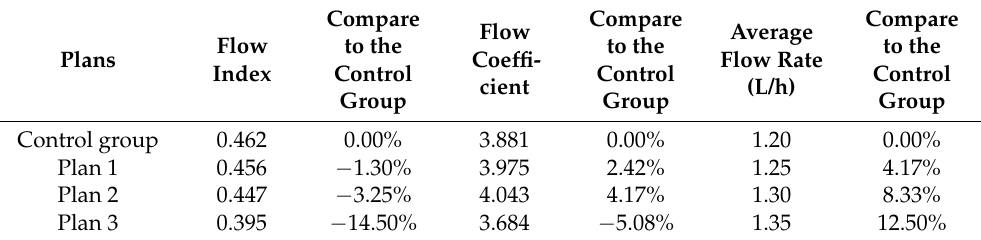
Table 4. The comparison of the hydraulic performance of the emitters in all the plans.